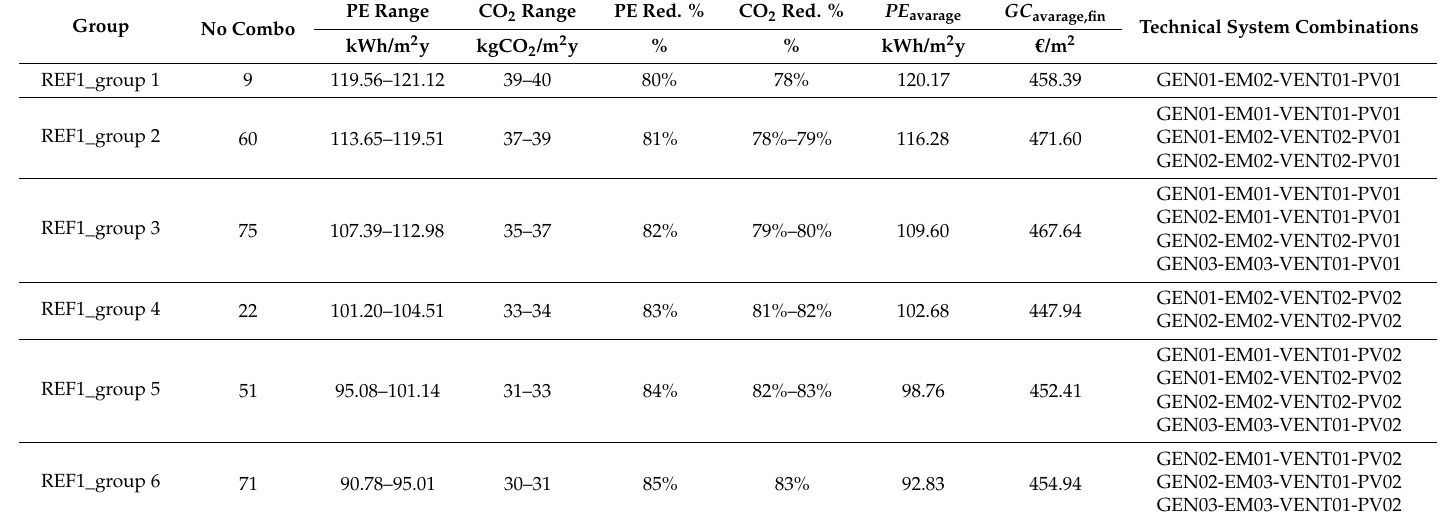
Table 6. Range of primary energy consumptions and global costs of combinations for REF1.